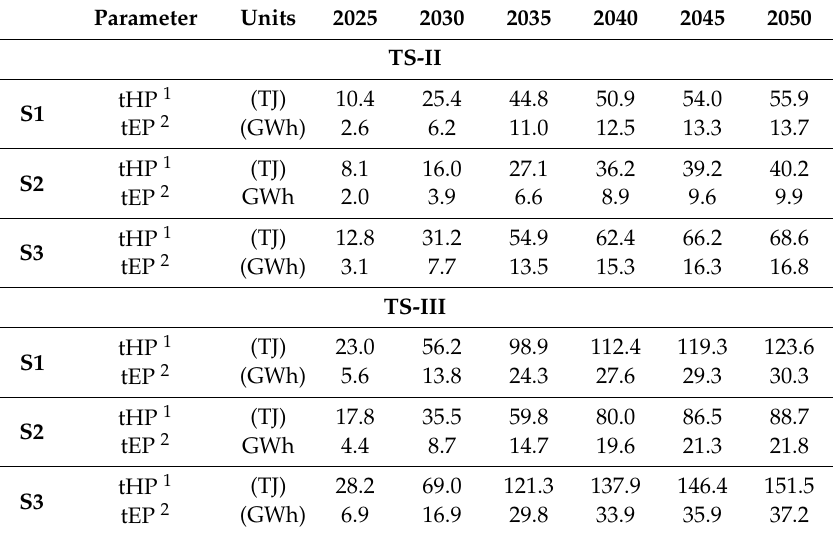
Table 7. TS-II and TS-III heat and energy generation